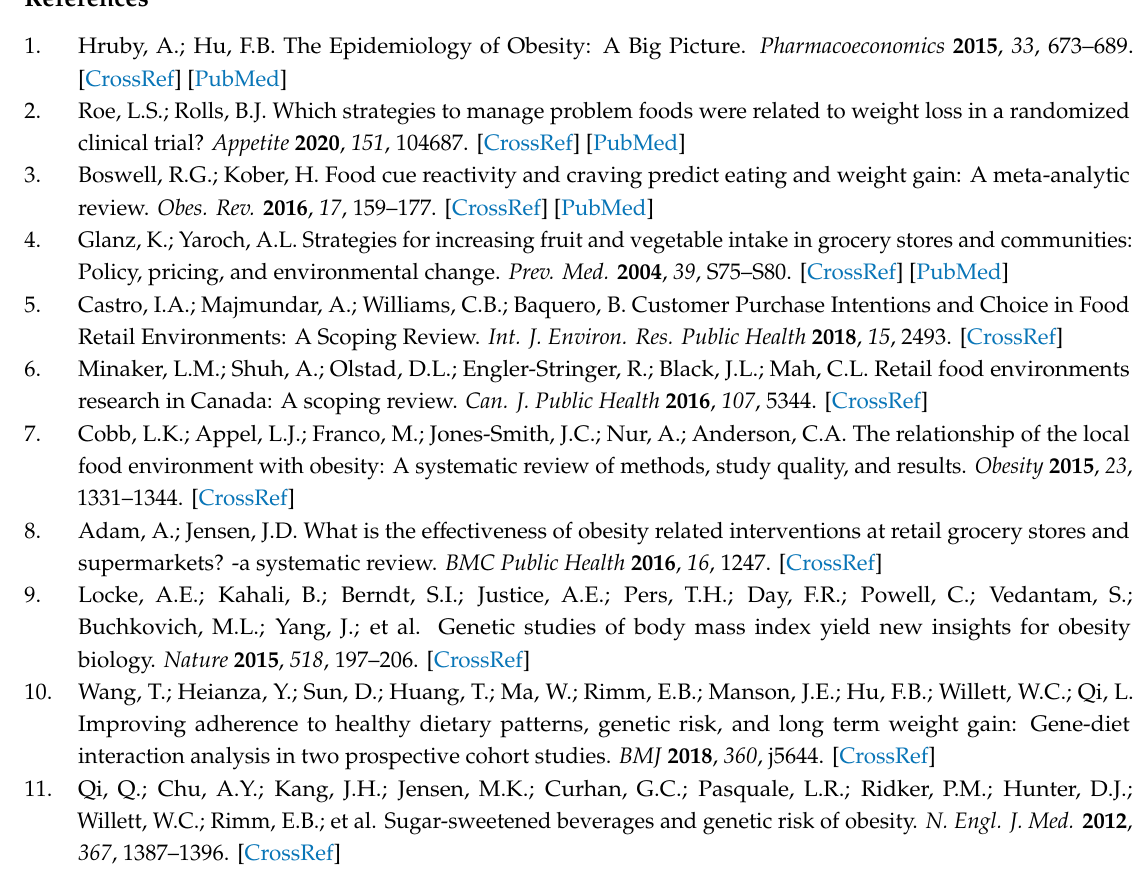
Figure S1: Participant flow chart, Figure S2: CARTaGENE FSAs represented in Quebec retail food environment data, Table S1: genetic variants associated with body mass index, Table S2: sensitivity analysis for genetic risk score and diet quality score main and interaction e ff ects on waist circumference, body mass index, and body fat percent, Table S3: participant characteristics of retail analysis sample, Table S4: mean and standard deviation of HEI-C score, waist circumference and BMI of PRS quintile in retail analysis sample, Table S5: mean of HEI-C individual components by PRS quintile in retail analysis sample, Table S6: 23 genes variants identified by Locke et al. are among the top 25 BMI susceptibility genes with highest expression in brain regions (insula and substantia